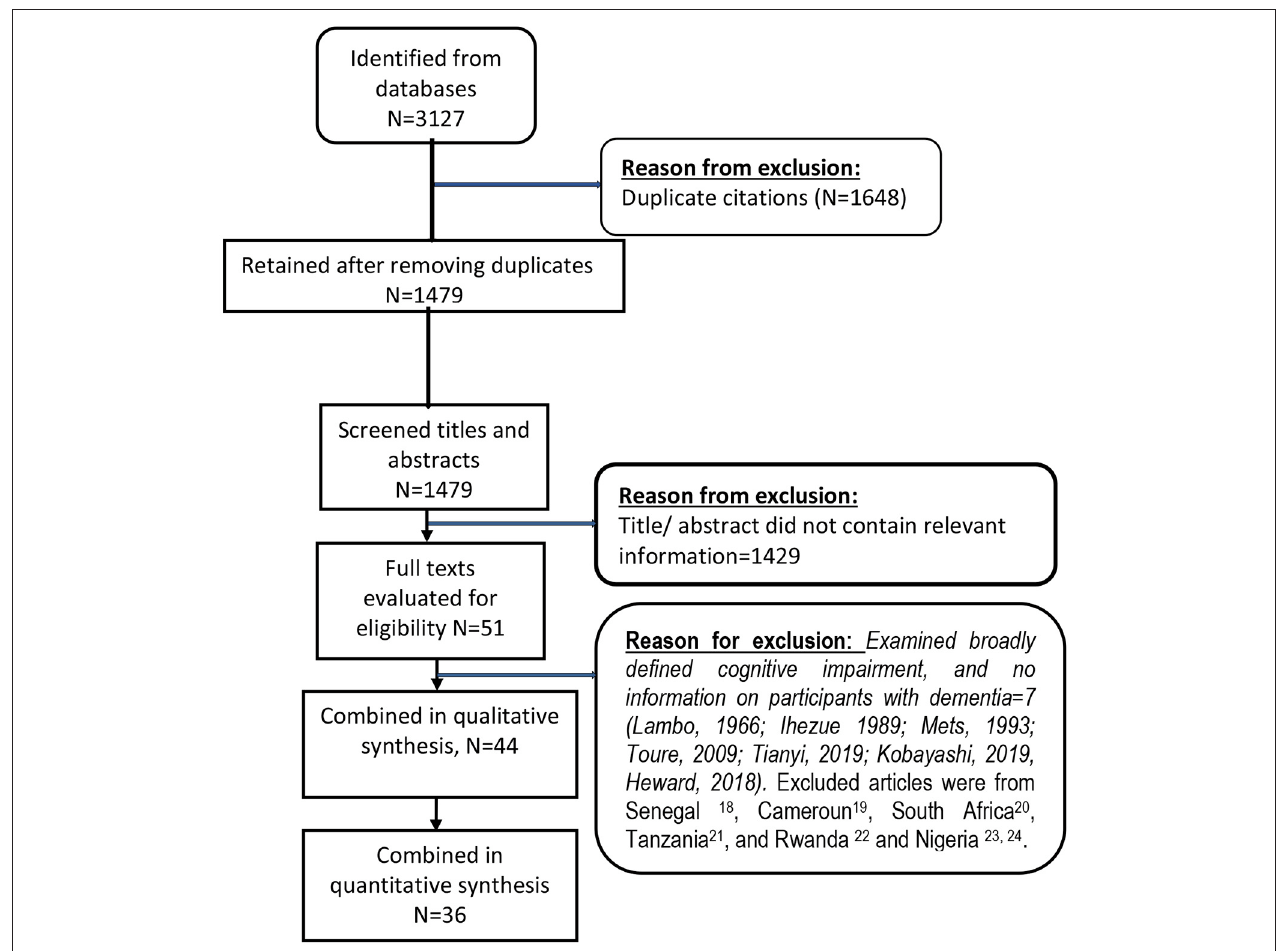
FIGURE 1 | Flow chart showing details of included and excluded